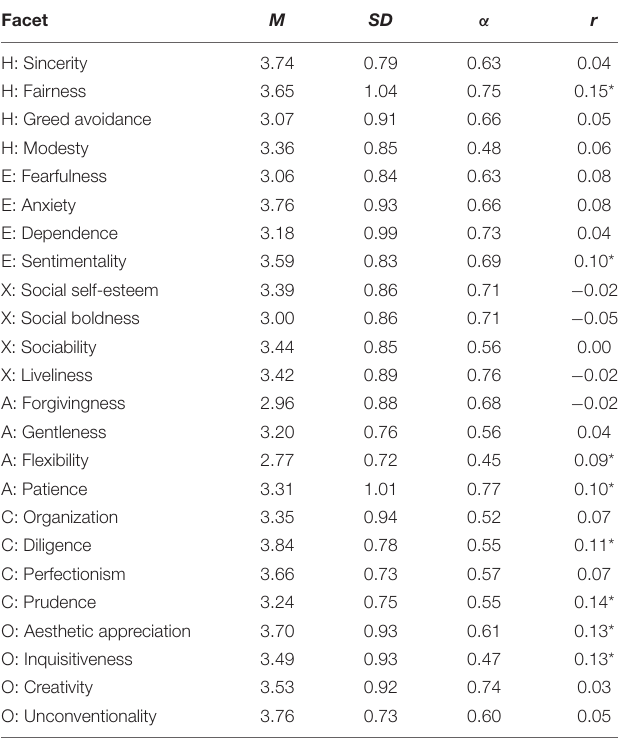
TABLE 2 | Descriptive statistics for personality facets and correlations with coronavirus disease 2019 (COVID-19) threat beliefs. Facet M SD α